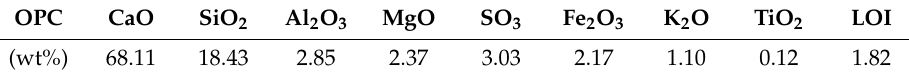
Table 2. Chemical composition of ordinary Portland cement.